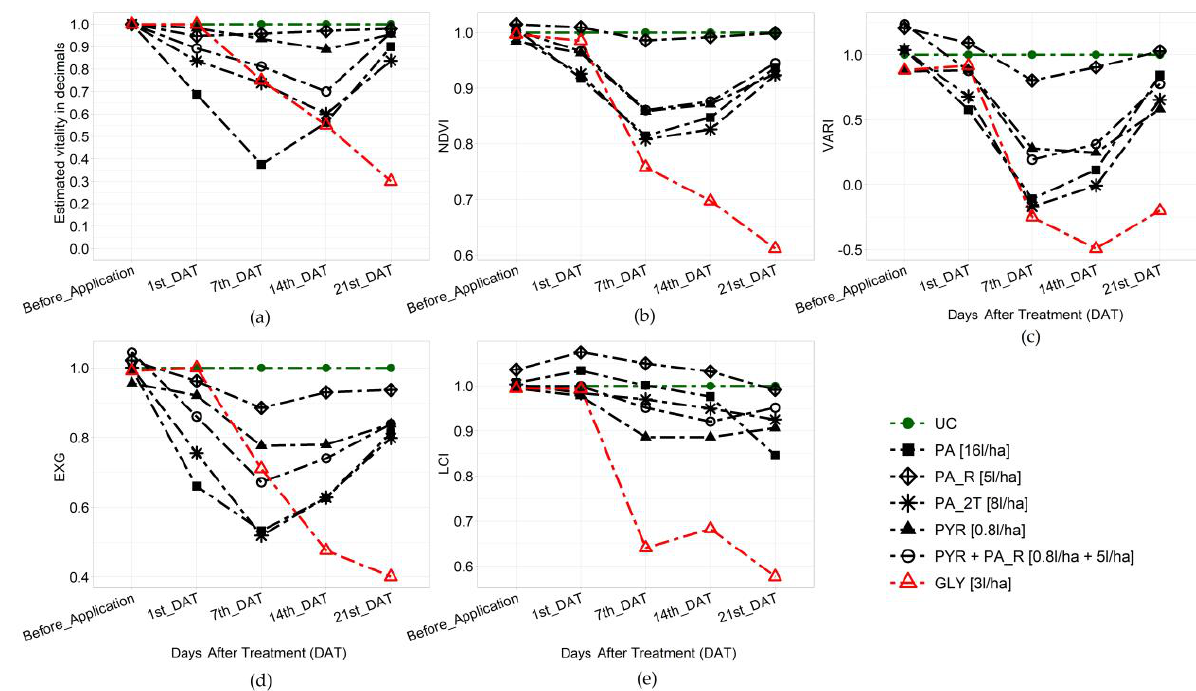
Figure 4. ( a ) Estimated crop vitality obtained by visual observation in 2019; ( b − e ): calculated VIs relative to the untreated control obtained by a drone in 2019.